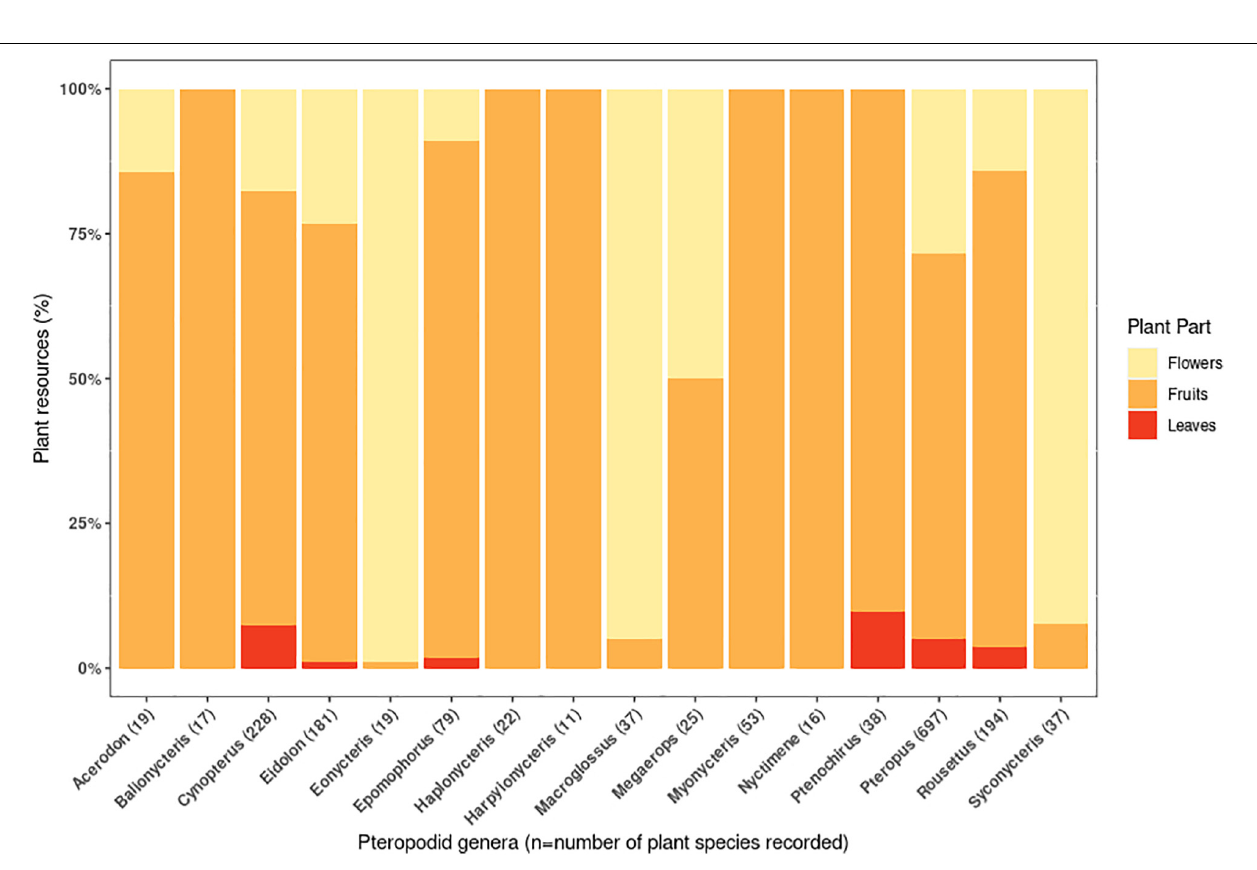
FIGURE 2 | Quantity of fruits, flowers and leaves recorded in the diets of pteropodid bats during 1985-2020. The quantity is represented by the proportion (percentage) of plant species consumed for each plant part, and is recorded for all studied species within 16 pteropodid genera. These genera fed on a minimum of 10 plant species recorded in the